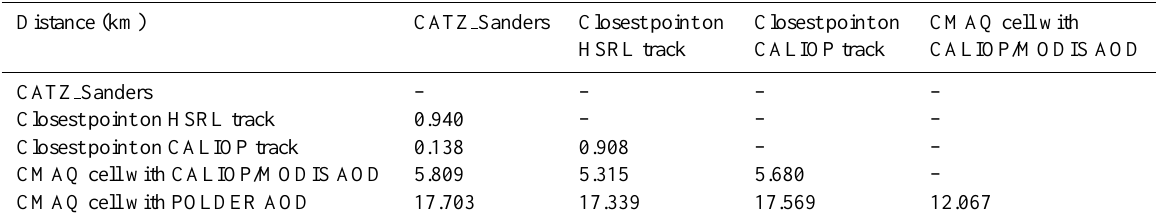
Table 3. 4 August 2007 – Distance (km) between the different measurements during the CATZ experiment; from top to bottom, the CATZ- Sanders AERONET station (white diamond, Fig. 2a), the closest point on the HSRL track to CATZ-Sanders (green line, Fig. 2a), the closest point on the CALIOP ground track to CATZ-Sanders (white line, Fig. 2a), the closest CMAQ cell to CATZ-Sanders containing a MODIS and CALIOP version 2 AOD value (red box, Fig. 2a) and the closest CMAQ cell to CATZ-Sanders containing a POLDER AOD retrieval (black box, Fig.